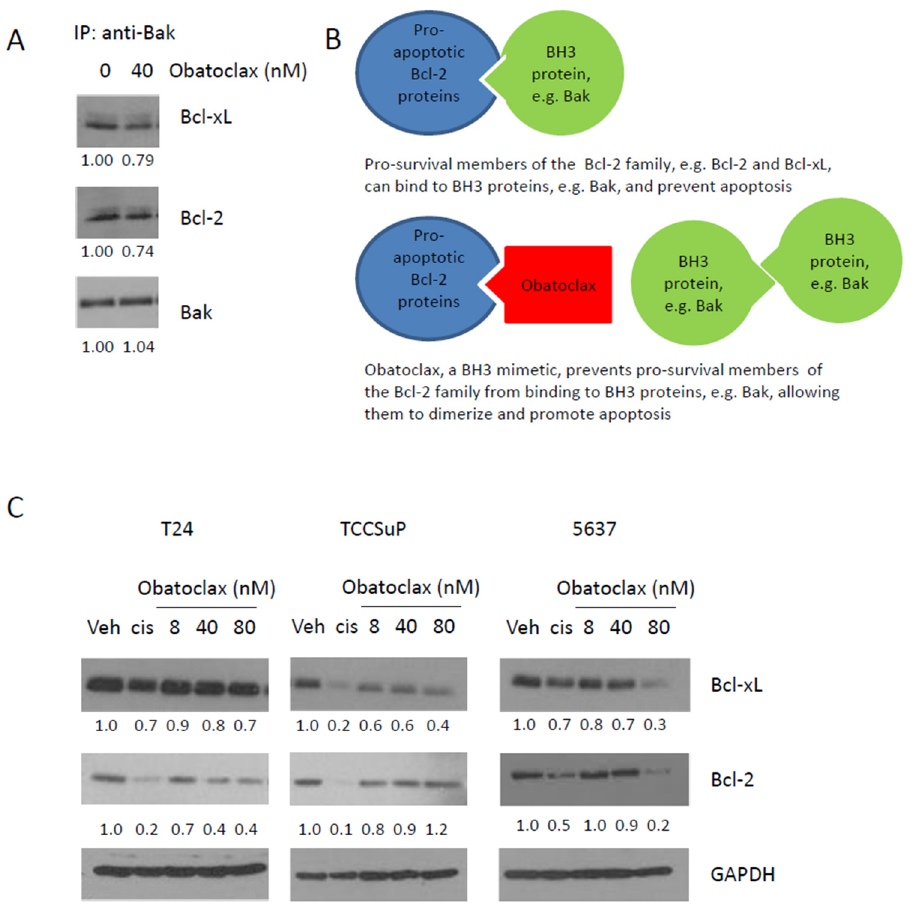
Figure 2. Obatoclax, a BH3 mimetic, is able to inhibit the binding of Bcl-2 and Bcl-xL to Bak and reduces Bcl-2 and Bcl-xL expression levels in muscle invasive bladder cancer cells. Immunoprecipitation analyses demonstrated that the treatment of 5637 cells with 40 nM Obatoclax caused a ~25% decrease in the binding of Bcl-2 and Bcl-xL to Bak ( A ); this finding aligns with the known mechanism of action of Obatoclax ( B ). Obatoclax also mediated reduced expression levels of Bcl-2 and Bcl-xL ( C ). A dose-dependent reduction in Bcl-xL was observed in T24, TCCSuP, and 5637 cells. A dose-dependent reduction in Bcl-2 was observed in T24 and 5637 cells, but not TCCSuP cells. immunoprecipitation, Veh = vehicle control, Cis = cisplatin).